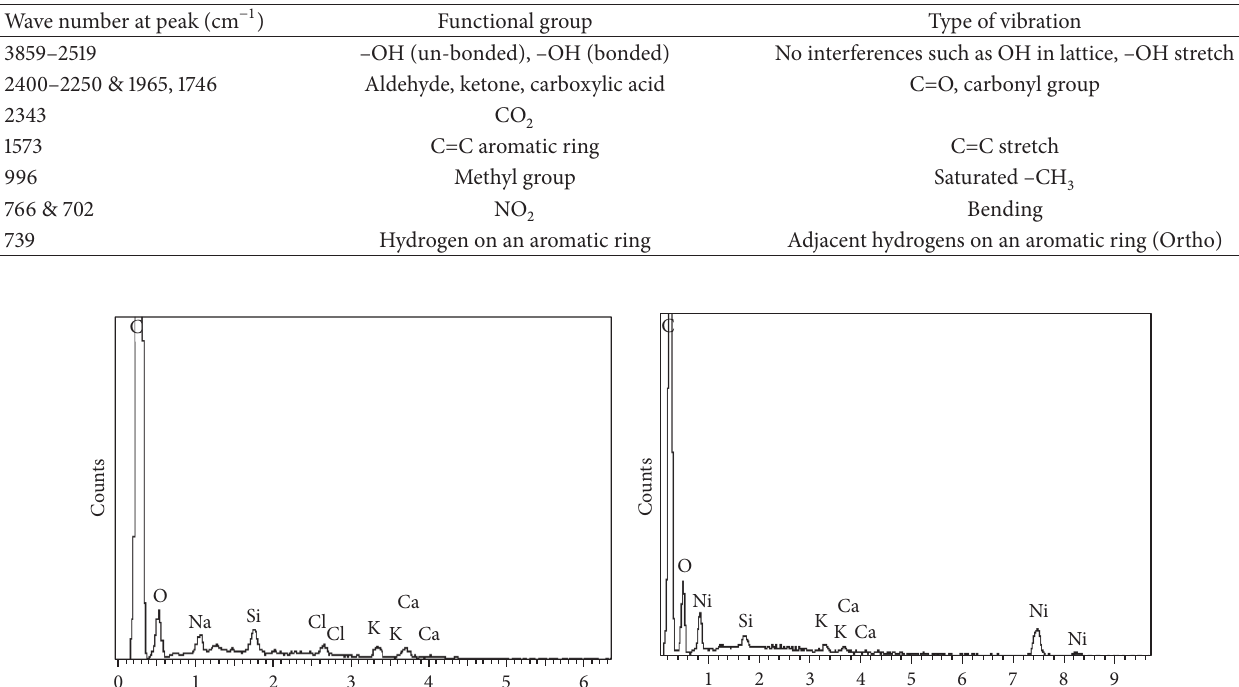
Table 3: Functional groups detected by FTIR on PAC, impregnated PAC, and PAC-CNF.